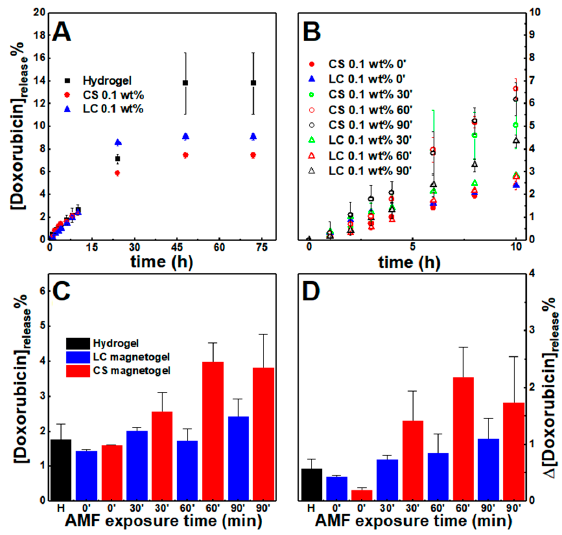
Figure 9. Cumulative doxorubicin percentage release profiles from the hydrogel and gels containing citrate-stabilized (CS) and lipid-coated (LC) nanoparticles (0.1 wt%) ( A ) without an externally applied alternating magnetic field (AMF) and ( B ) comparison of the magnetogels release when an AMF is applied for 30, 60, and 90 min between t = 4 h and t = 6 h. ( C ) Cumulative doxorubicin released at t = 6 h. ( D ) Variation of doxorubicin percentage released between t=4 h and t = 6 h, that is, for a period of 2 h.